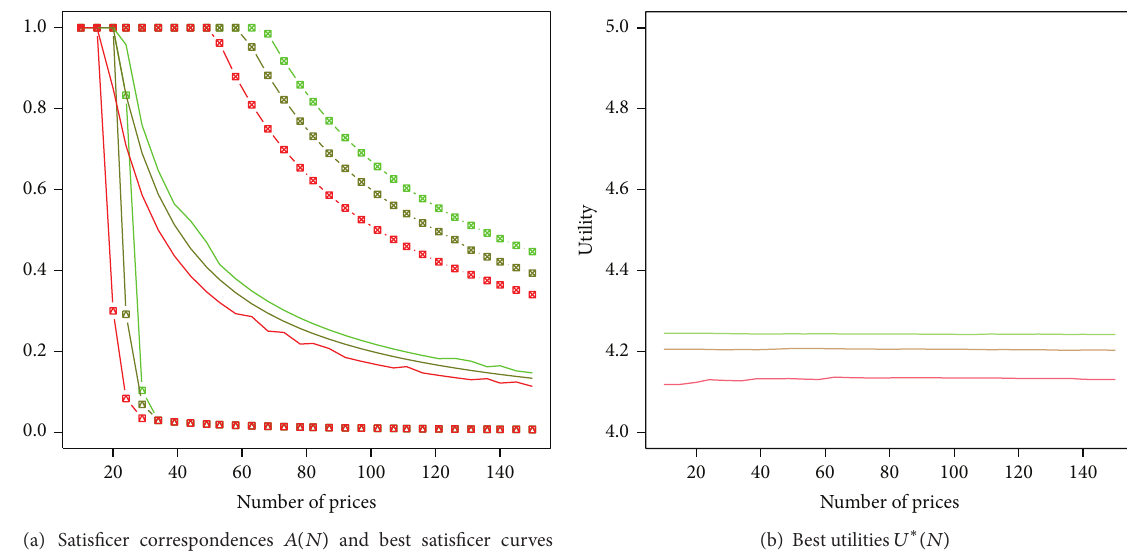
Figure 7: Analysis of satisficing behavior for a dispersion-preserving mean shift under a normal distributions Color of graphs shifts from green to red as 𝜇 increases (see Table 3).